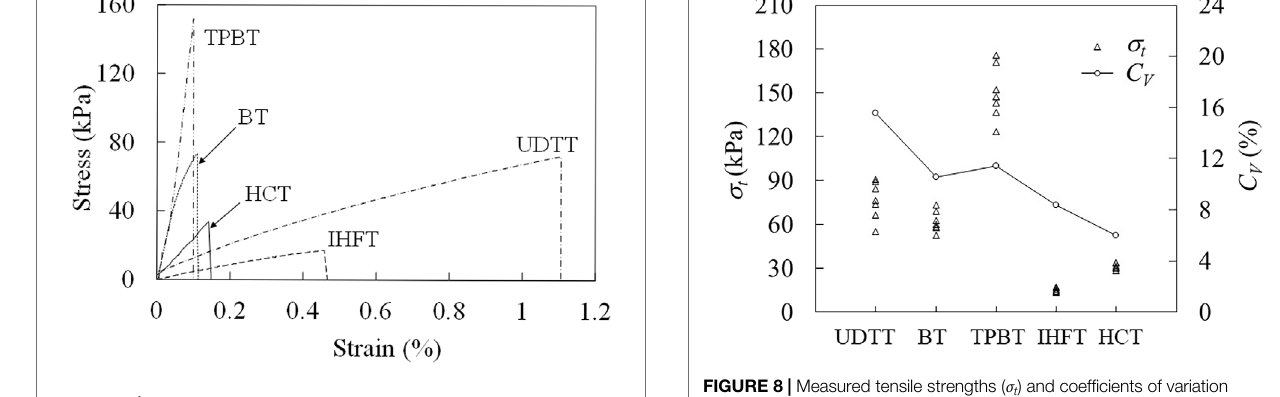
FIGURE 6 | Typical stress – strain curves from different test methods. Data sources for BT, HCT and UDTT are from Guan et al. (2022).